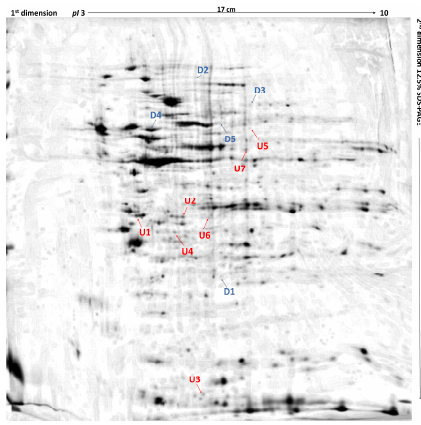
Figure 1. Differentially expressed proteins in feline fibrosarcomas from doxorubicin-resistant and doxorubicin-sensitive cell lines. U1 and U2, up-regulated proteins in both FFS1 versus FFS5 and FFS3 versus FFS5; D1, down-regulated protein in both FFS1 versus FFS5, and FFS3 versus FFS5; U3–U7, up-regulated proteins in FFS1 versus FFS5; D2–D5, down-regulated proteins in FFS1 versus FFS5. Up-regulated proteins are indicated in red, and down-regulated proteins are indicated in blue. Merged two-dimensional electrophoresis gels of representative tissue lysates of tumours from FFS1, FFS3, and FFS5 cell lines. Proteins were separated in the first dimension by isoelectric focusing over the isoelectric point (pI) range 3–10. The second dimension was performed using 12.5% sodium dodecyl sulfate polyacrylamide gel. Gels were silver stained, digitised, and processed in Delta2D software (version 4.7 DECODON Greifswald, Germany).